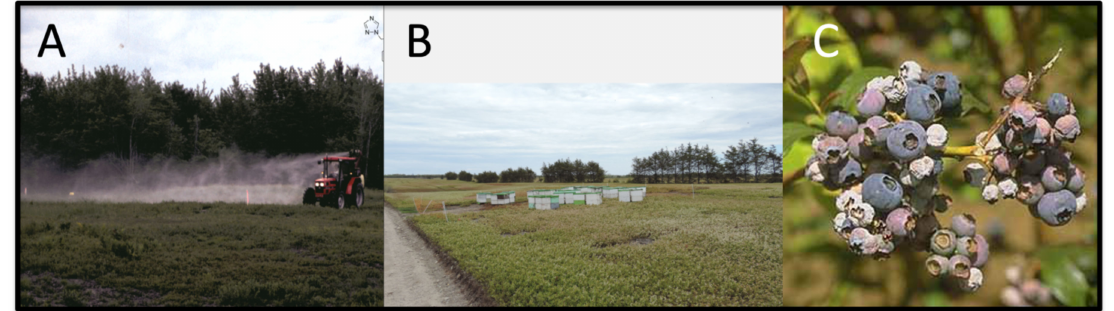
Figure 1. Orbit ® (active ingredient: propiconazole) being applied with an air-blast sprayer to a low- bush blueberry field prior to bloom just after an infection period had been forecast ( A ). Honey bee hives deployed in clusters throughout a lowbush blueberry field in bloom ( B ), The results of mummy berry disease infection, shriveled hard white fruits are mummies (pseudosclerotia) ( C ). The application of fungicides in blueberry to control mummy berry disease either just prior to bloom as in lowbush blueberry production, or during bloom as in highbush blueberry production, begs the question: what is the exposure and effect of these fungicides in the spring during bloom on pollinators, specifically migratory honey bees that are brought into fields to maximize